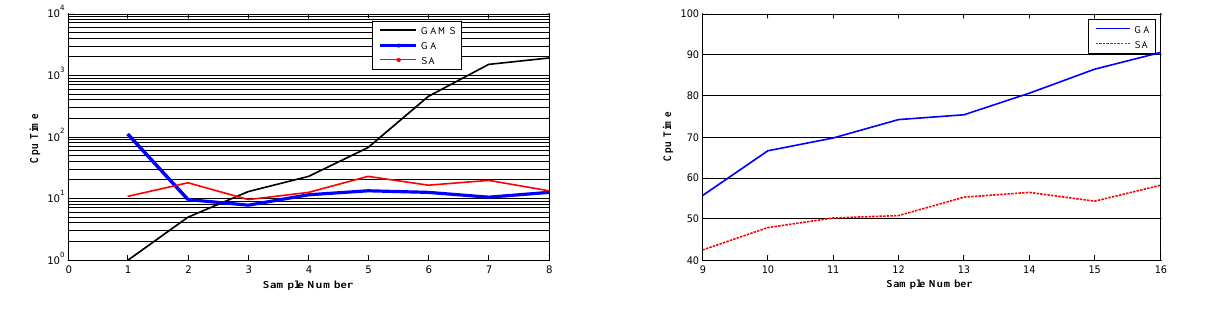
Fig. 4. Comparison of computational time of the GAMS, GA and SA in small problems